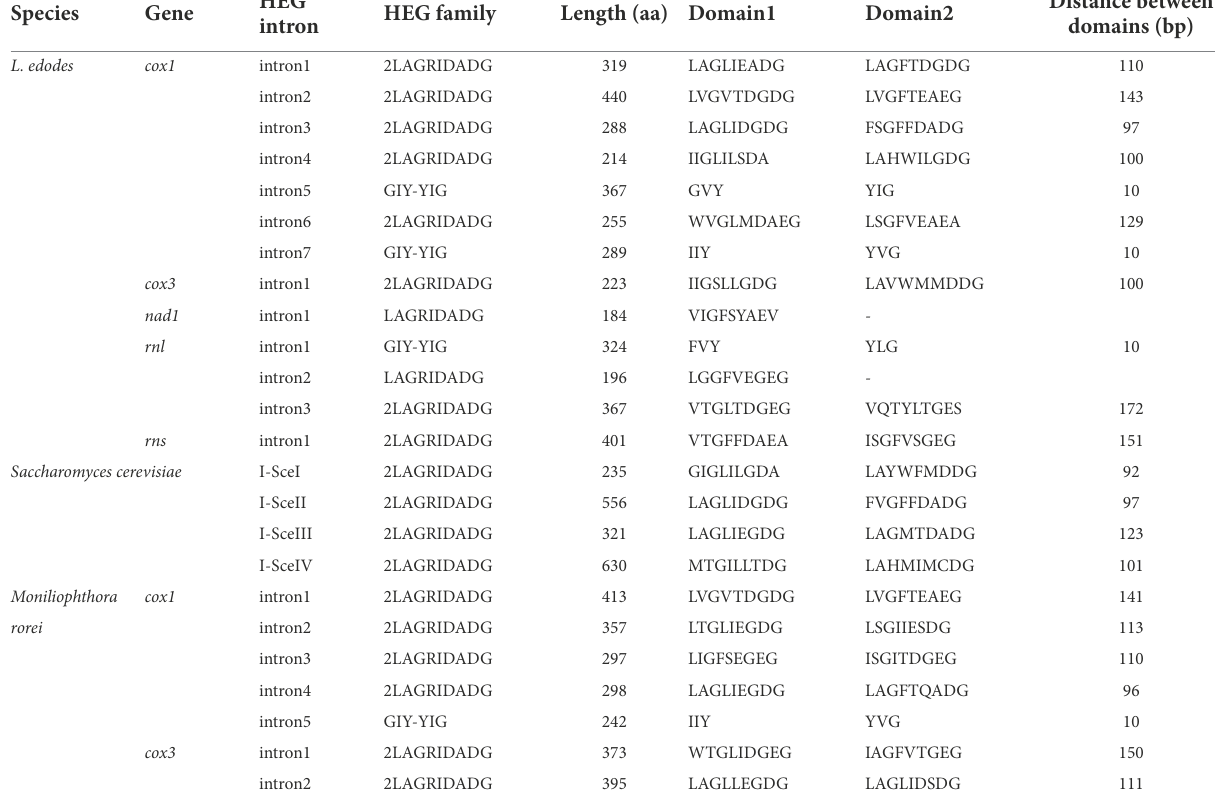
TABLE 2 Homing endonucleases in L. edodes mtDNAs.